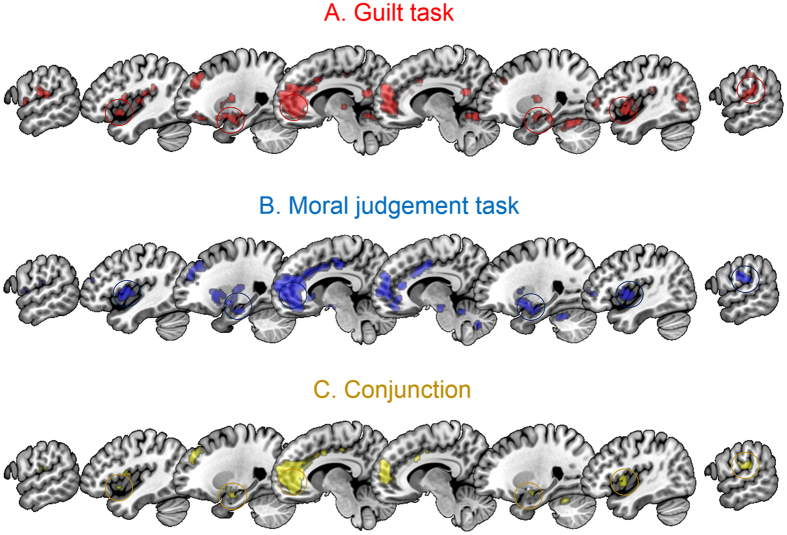
Neural correlates of everyday moral transgressions.Main effects (harm-to-other > harm-to-self) of the guilt task (A), the moral judgment task (B) and their conjunction (C). Significant activations across both tasks are present in the left anterior insula, left amygdala, ventromedial prefrontal cortex, right amygdala, right anterior insula and right supramarginal gyrus (highlighted, from left to right). Overlays are thresholded at p < 0.001 (uncorrected) and superimposed on the MNI 152 template brain provided in MRIcroGL40 for illustrative purposes.